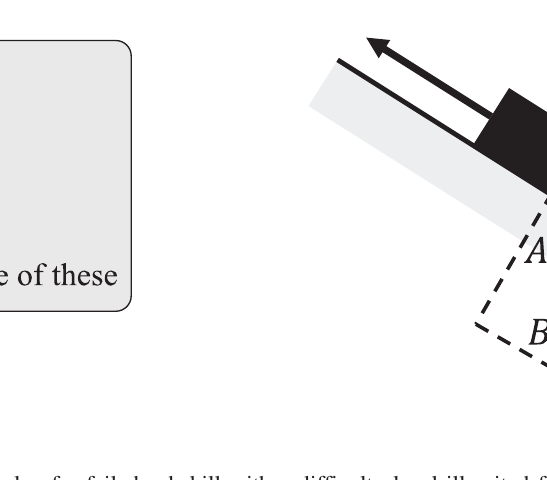
FIG. 8. Example of a failed subskill with a difficulty level ill-suited for a specific student